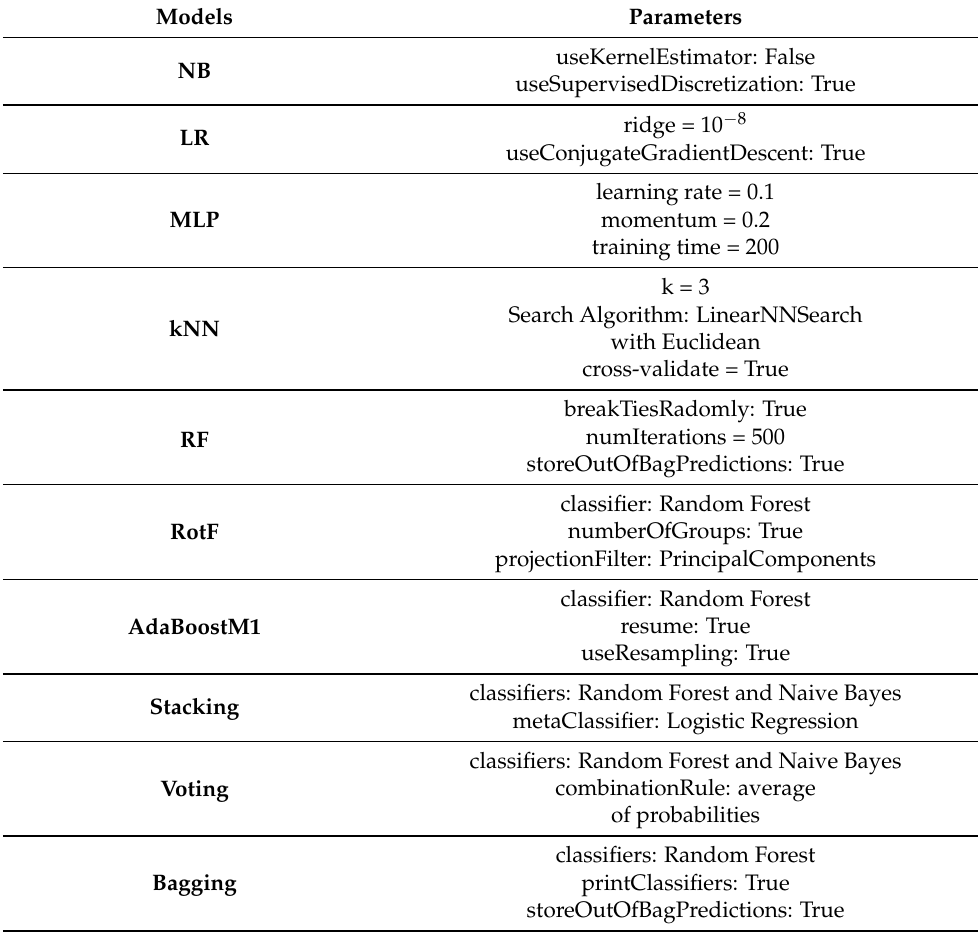
Table 9. Machine Learning Models’